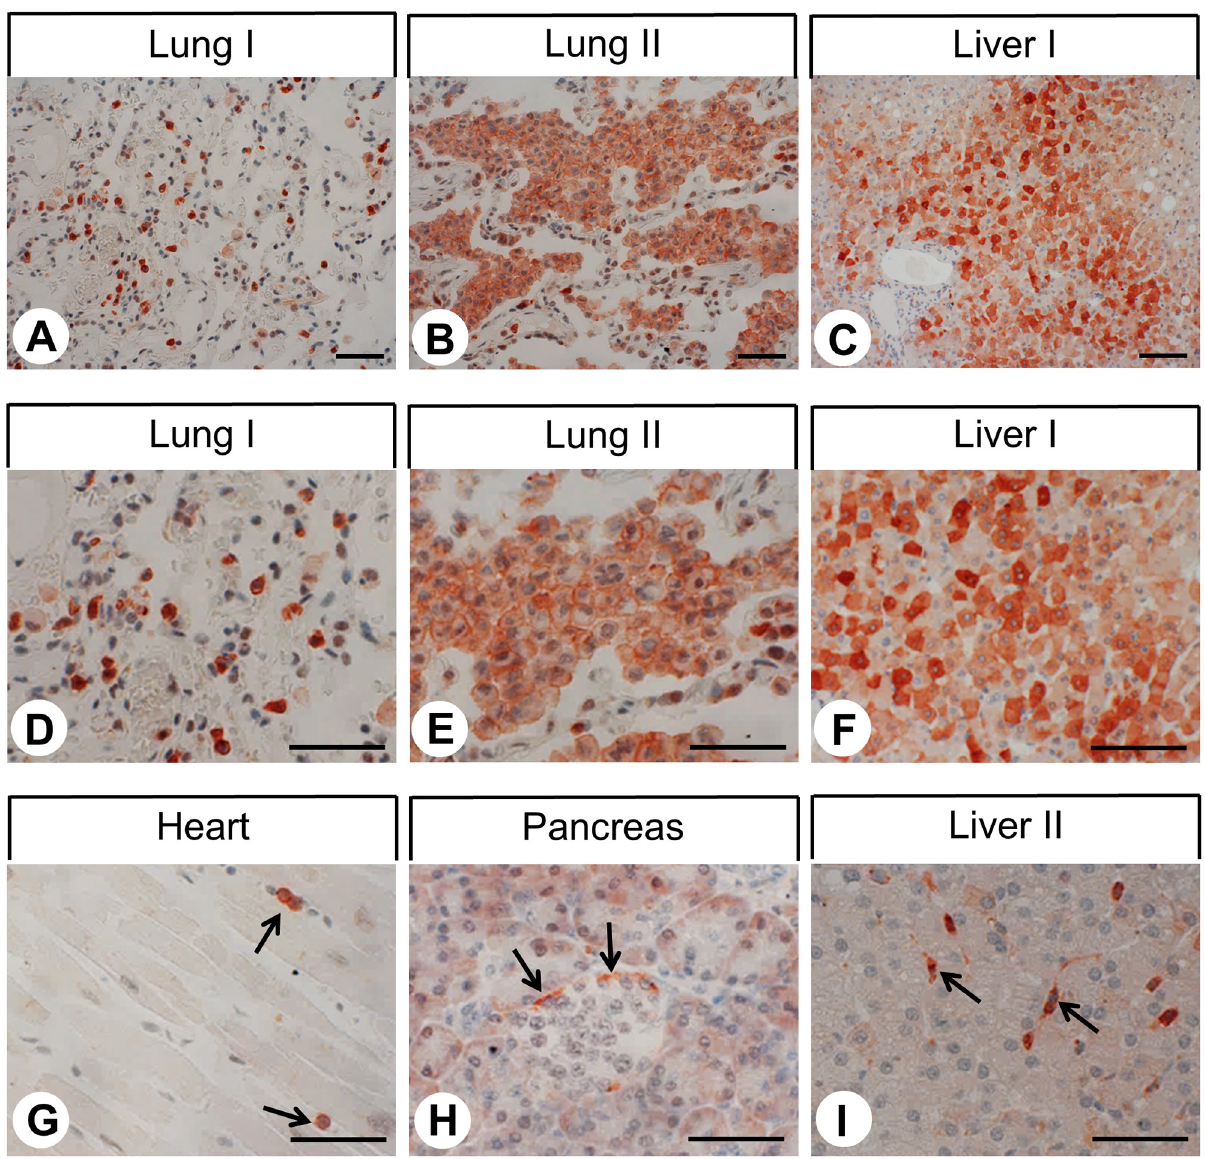
Fig 3. Immunohistochemical detection of C5aR1 localisation in non-neoplastic human tissues (I). Immunohistochemical staining (red-brown colour), counterstaining with haematoxylin. Scale bar: 100 μ m (C, F), 50 μ m (A, B, D, E, G-I). Arrows in (G): positive immune cells in the heart; arrows in (H): positive cells at the margin of the pancreatic islet; arrows in (I): positive Kupffer cells in the liver. (D-F) enlarged sections of (A-C).